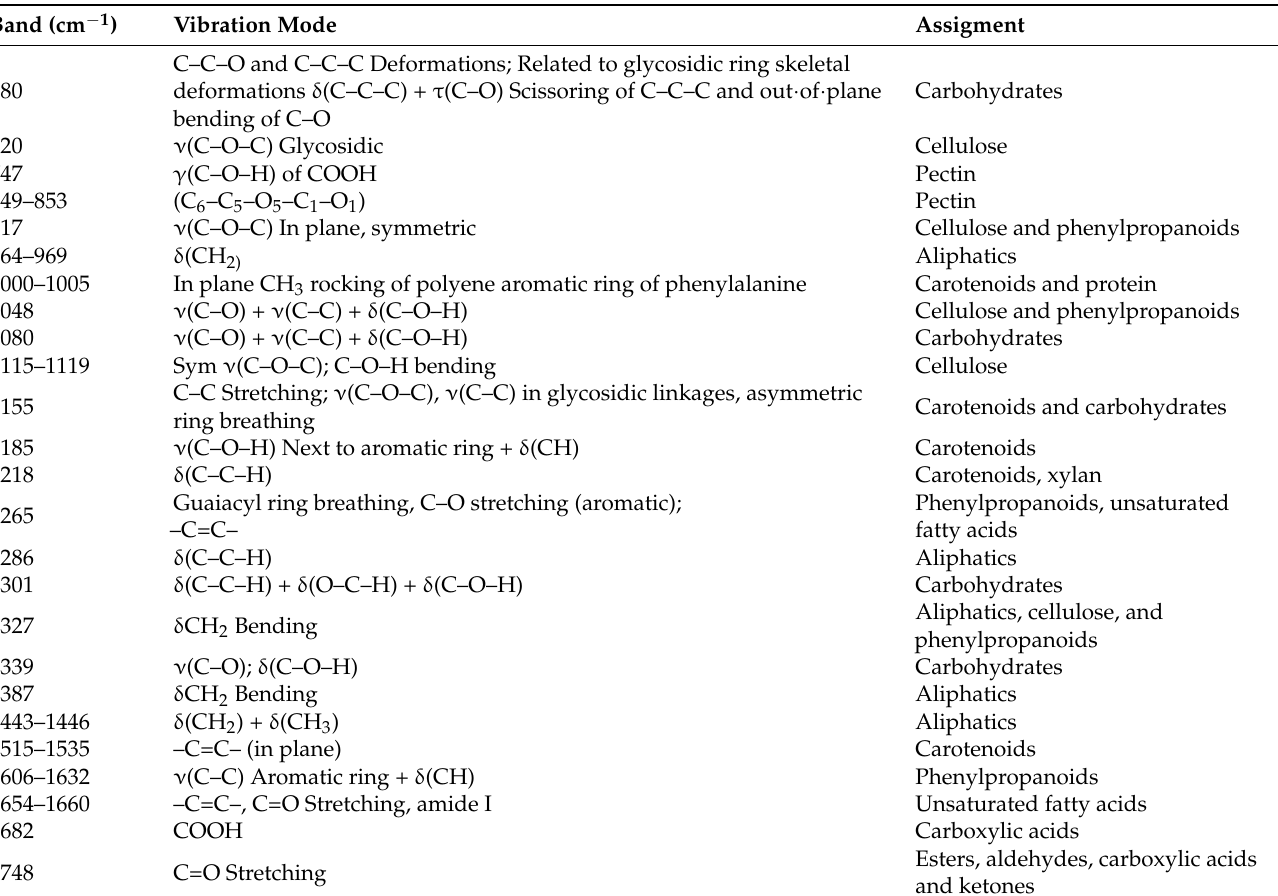
Table 1. Assignment of bands in the Raman spectra of cell wall polysaccharides based on the literature [8]. Copyright Front. Plant Sci.